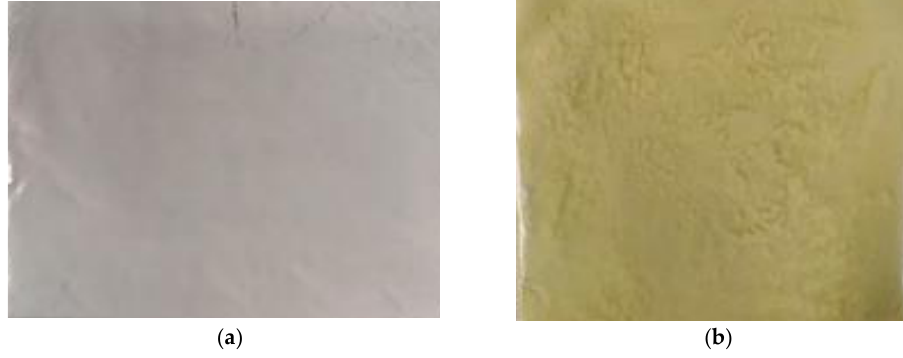
Figure 7. Color change in NaRE(SO 4 ) 2 ·H 2 O ( a ) and RE(OH) 3 ( b ).